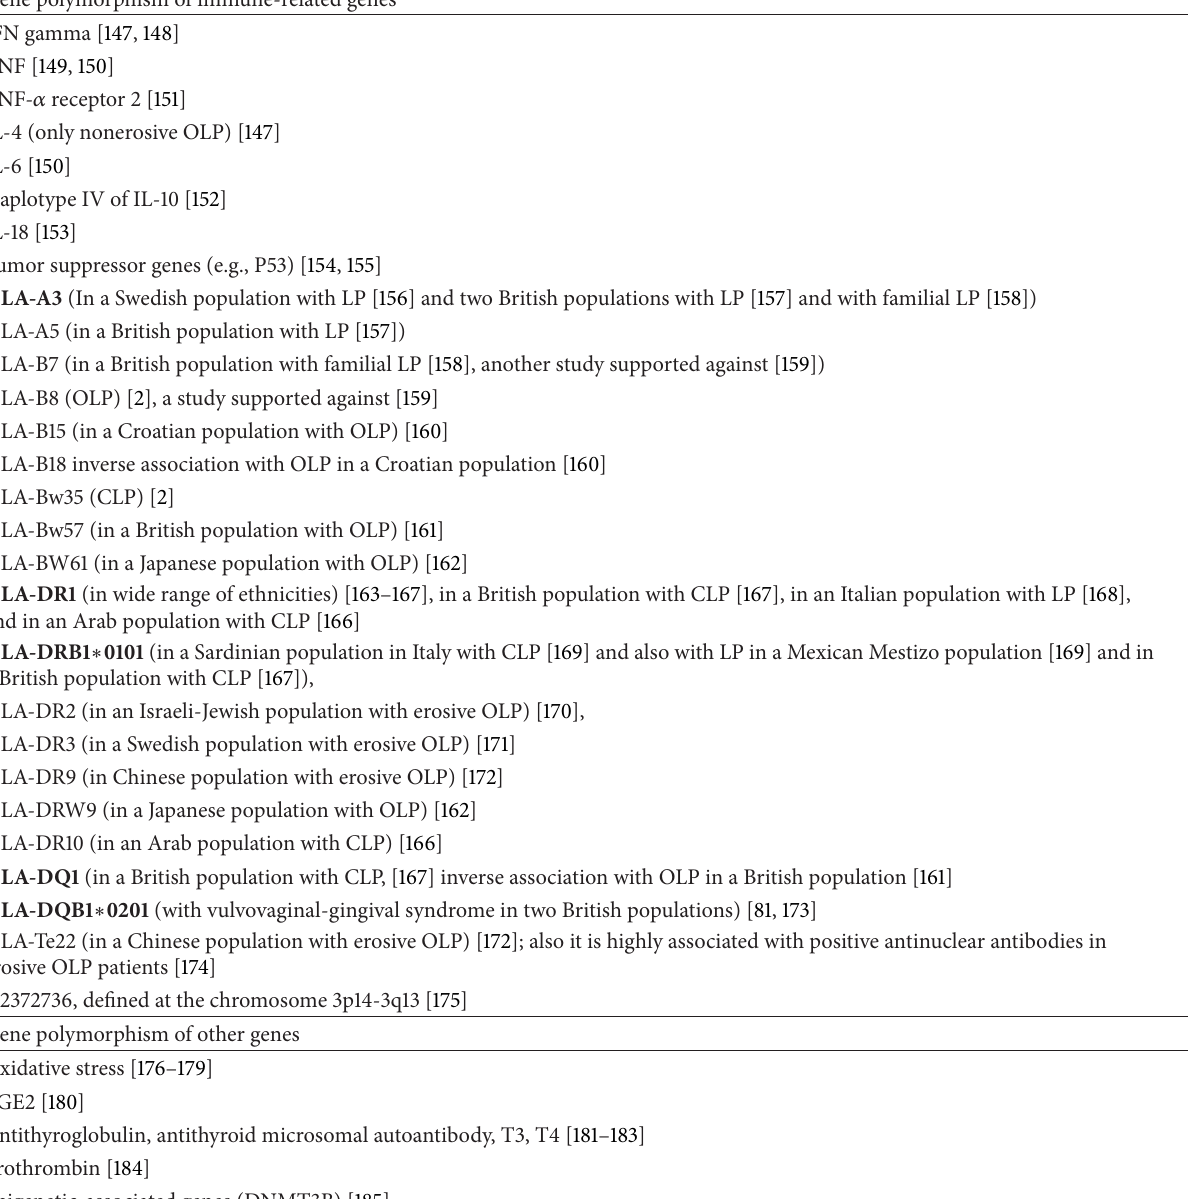
Table 6: Suggested gene polymorphisms that are associated with